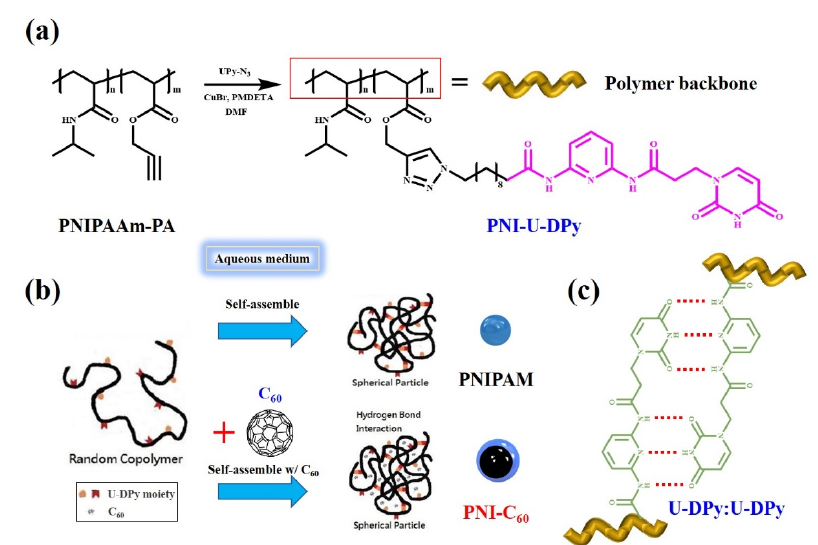
Scheme 1. ( a ) Synthesis of PNI-U-DPy; ( b ) Schematic illustration of supramolecular micelles formed by the strong U-DPy:U-DPy complementary multiple hydrogen bonding – interactions and the formation of C 60 -loaded micelles; ( c ) Illustration of complementary hydrogen – bonding interaction within PNI-U-DPy.